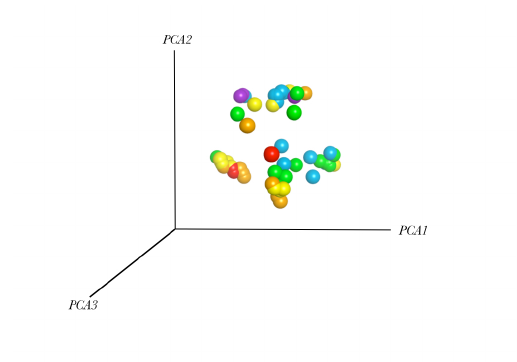
Fig. 4: The 3 D plot of the first three principal compo- nents. Each point represents a compound in the training dataset and each colour represents a distinct cluster of pIC 50